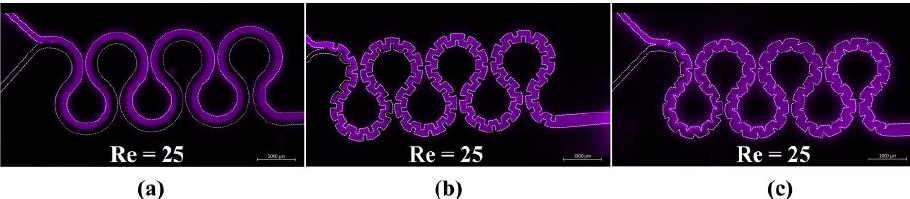
Figure 1. The fluorescence intensity maps of micromixer M1 ( a ), M3 ( b ), and M7 ( c ) at Re = 25 [6]. Copyright 2021, Elsevier.